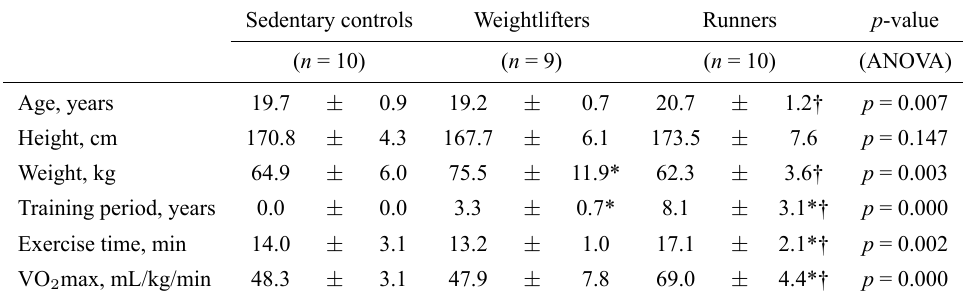
Table 1. Physical characteristics of subjects.